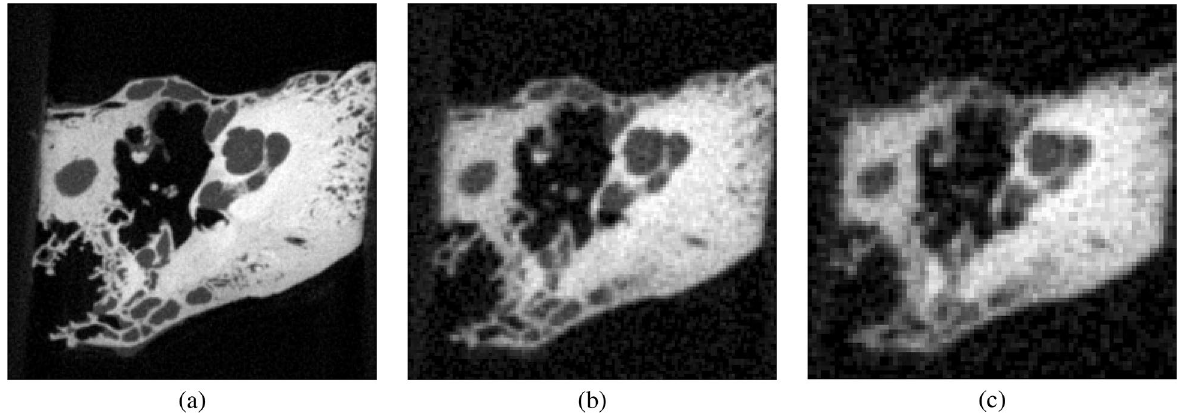
Figure 2. Pseudo-clinical data. ( a ) Next-generation pseudo-clinical CBCT ( 0.15mm voxels). ( b ) Standard pseudo-clinical MDCT ( 0.3mm voxels). ( c ) Poor pseudo-clinical MDCT ( 0.45mm voxels). Note that there is no convenient way to quantify noise levels other than relative to each other. Expressed arbitrarily as the value of wxDicom’s Detection Noise slider, the added noise was 60dB for the next-generation CBCT data, 70dB for the standard MDCT data and 75dB for the poor MDCT